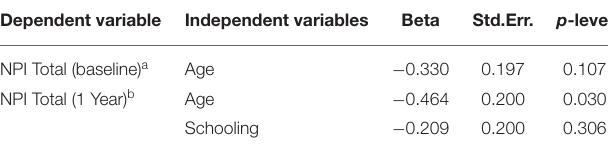
TABLE 4 | Linear regression analysis for NPI total score (baseline and 1-year follow-up) among bvFTD patients. Dependent variable Independent variables Beta